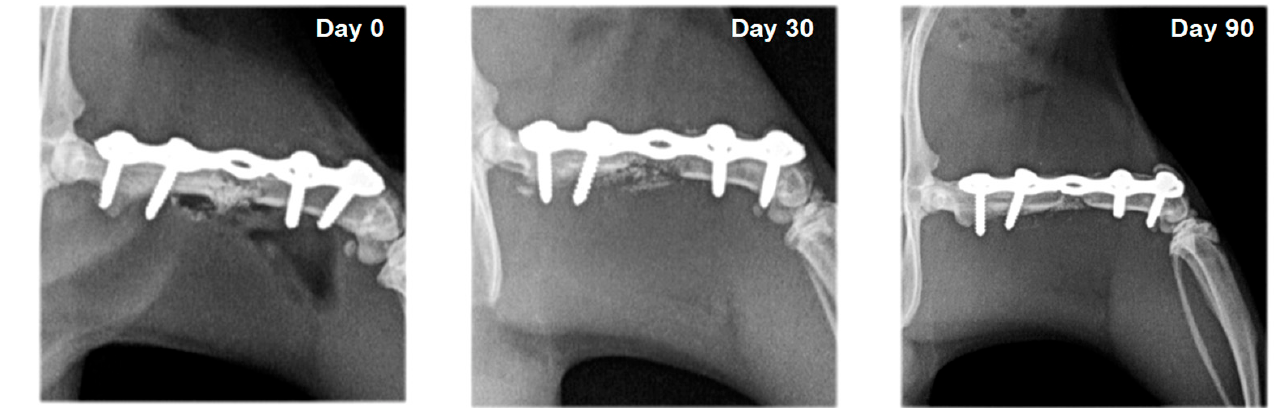
Figure 7. Serial craniocaudal radiographs of rat femurs from experimental group F5 on post-operative days 0, 30 and 90.